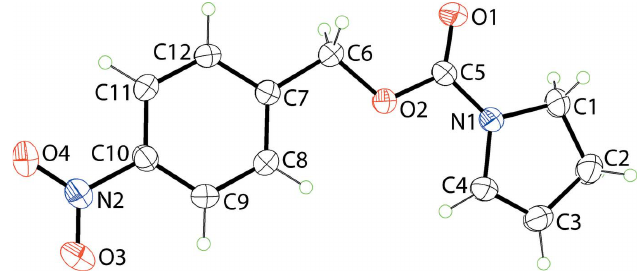
Figure 1 The molecular structure of (I), showing the atom-labelling scheme and displacement ellipsoids at the 35% probability level.